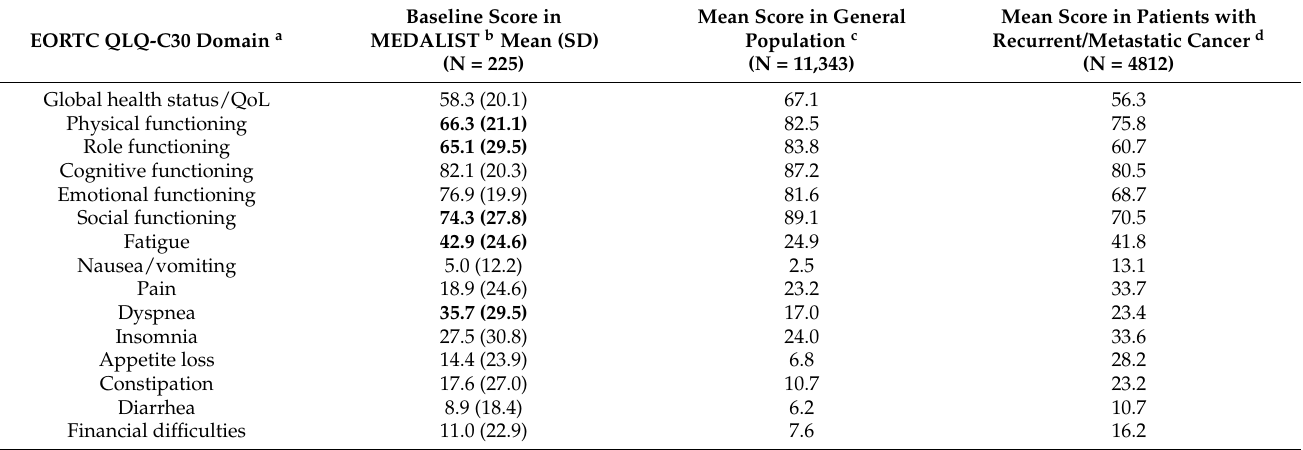
Table 2. EORTC QLQ-C30 scores in the MEDALIST trial at baseline, in the general population, and in patients with recurrent or metastatic